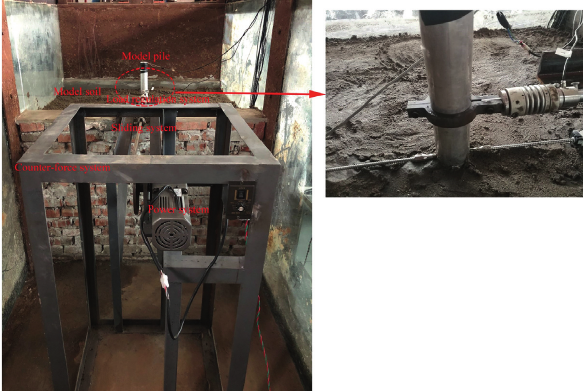
Figure 4: Schematic diagram of test